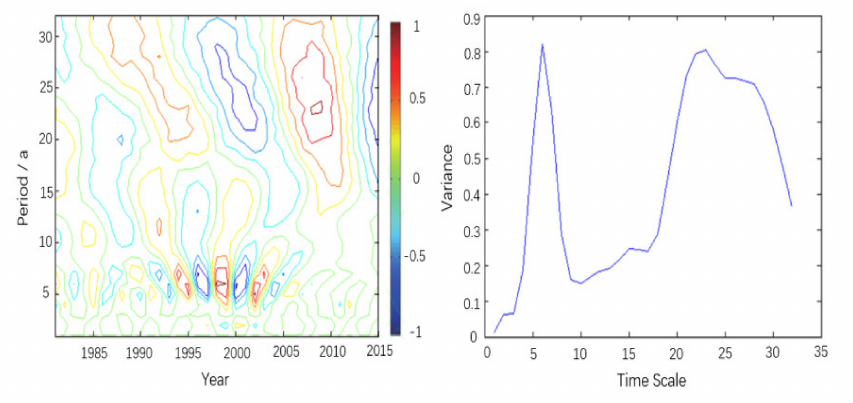
Figure 6. Wavelet time series analysis of spring VCI in China, 1981–2015.